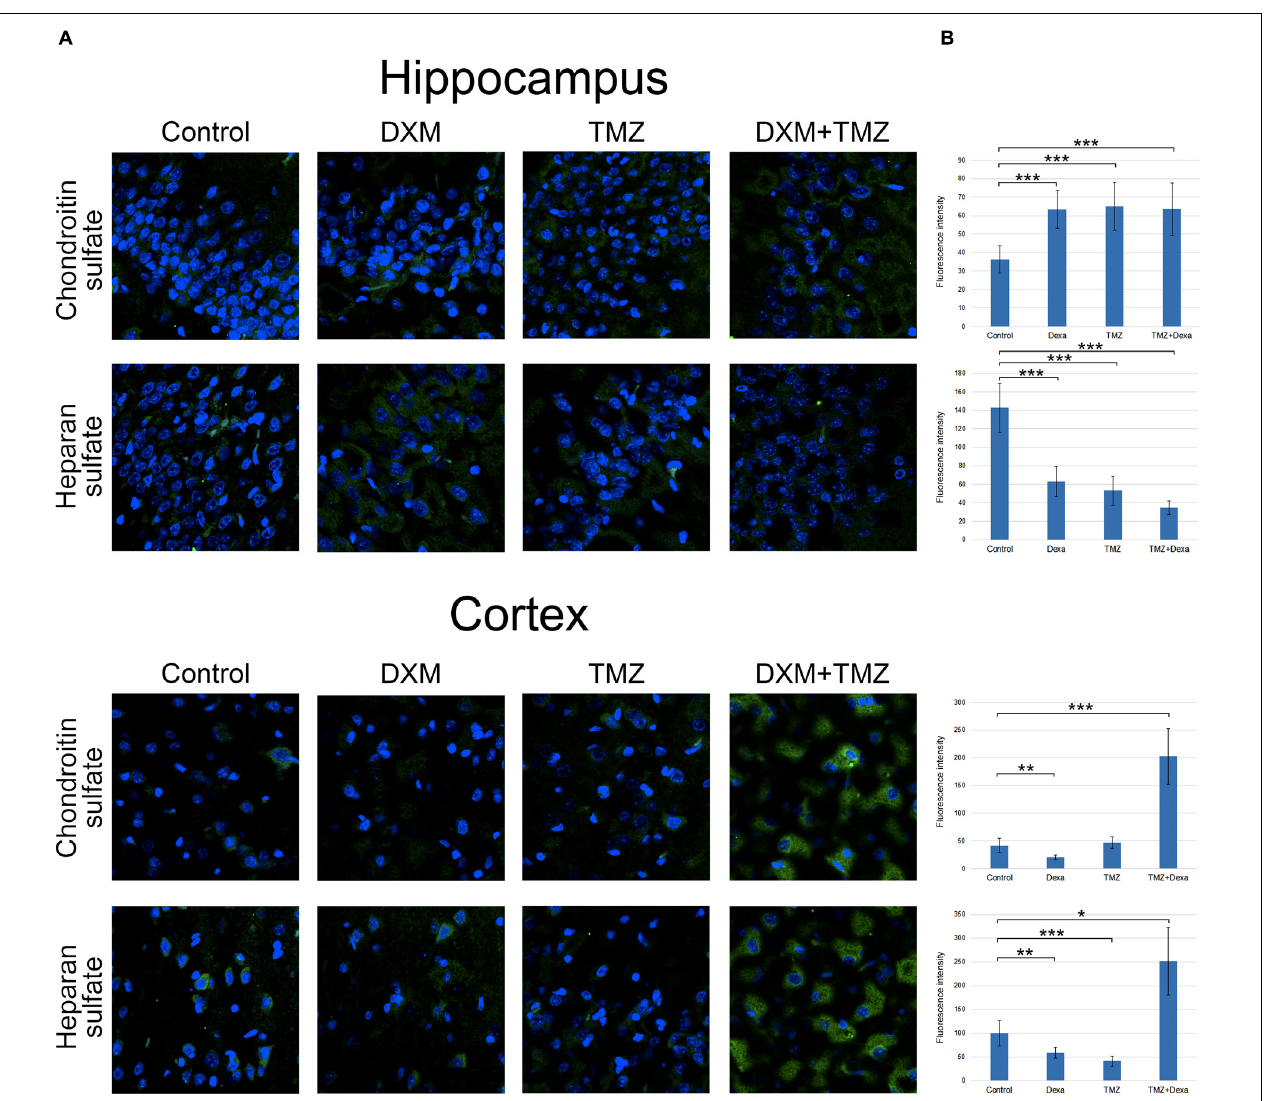
FIGURE 6 | Immunofluorescence analysis of GAGs content in rat brain before and after treatments with DXM and/or TMZ. (A) Immunofluorescence analysis with anti-HS and anti-chondroitin sulphate antibodies. Visualization with secondary antibodies Alexa Fluor 488 (green). Magnification ∗ 400. (B) Quantitative analysis of the GAGs content in the control and treated rat brain tissues (CellProfiler 2.2.0 software). Student’s t -test, ∗ p < 0.05, ∗∗ p < 0.01 and ∗∗∗ p < 0.001.